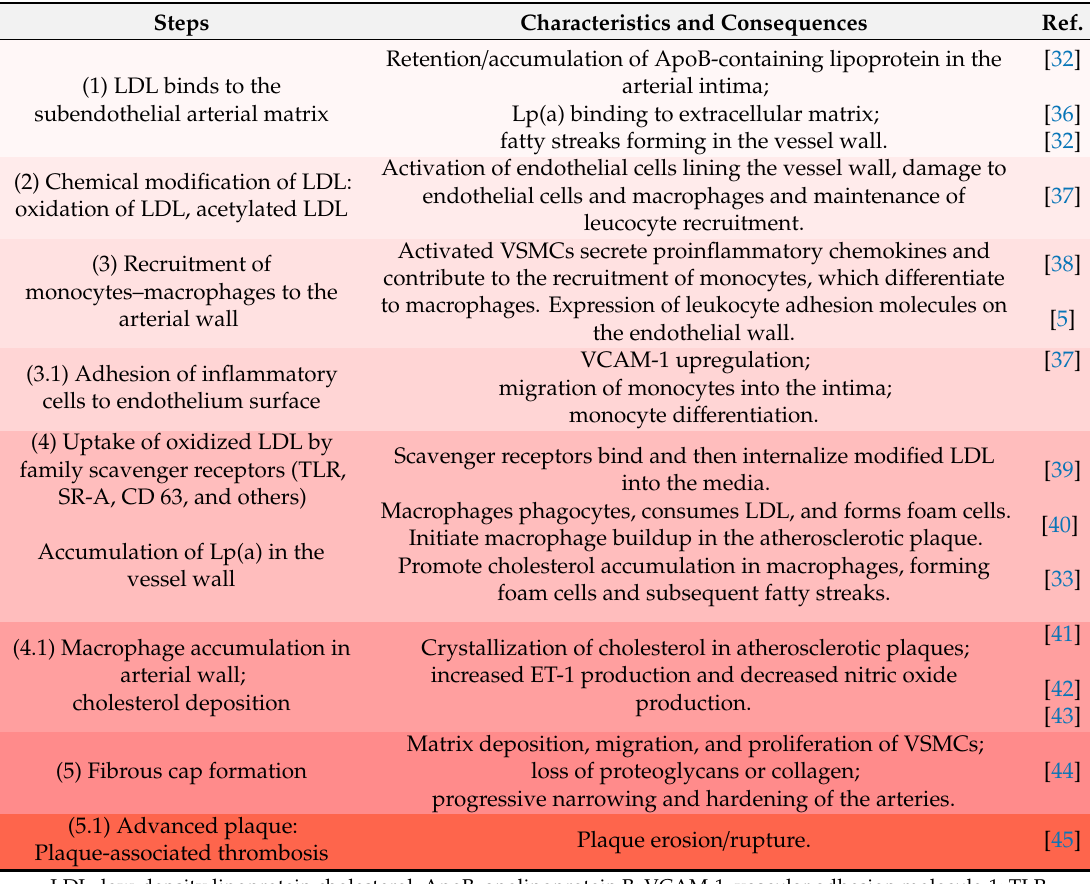
Table 1. Summary of atherosclerosis plaque genesis steps and associated